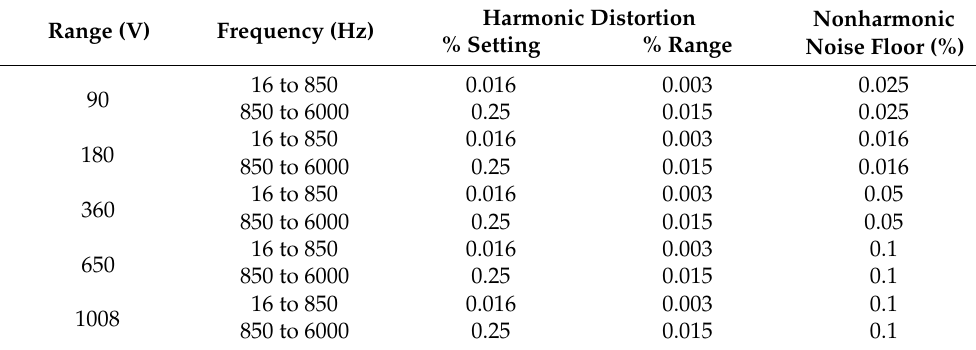
Figure 2. Main features of the fluke calibrator. Table 3. Contains all the relevant features of the Fluke 6105A calibrator.